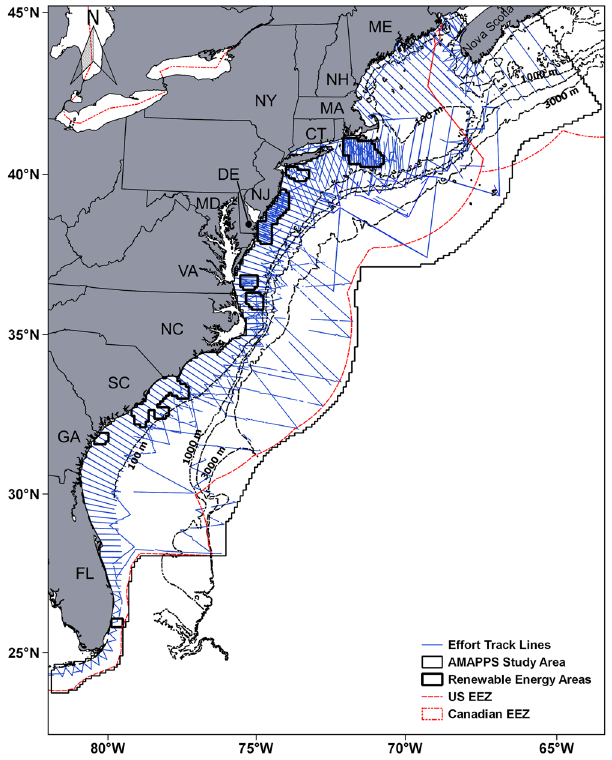
Figure 1. Effort track lines in the AMAPPS study area during 2010–2013, most track lines were surveyed multiple times by shipboard and aerial surveys. Renewable energy areas include a 10 km buffer